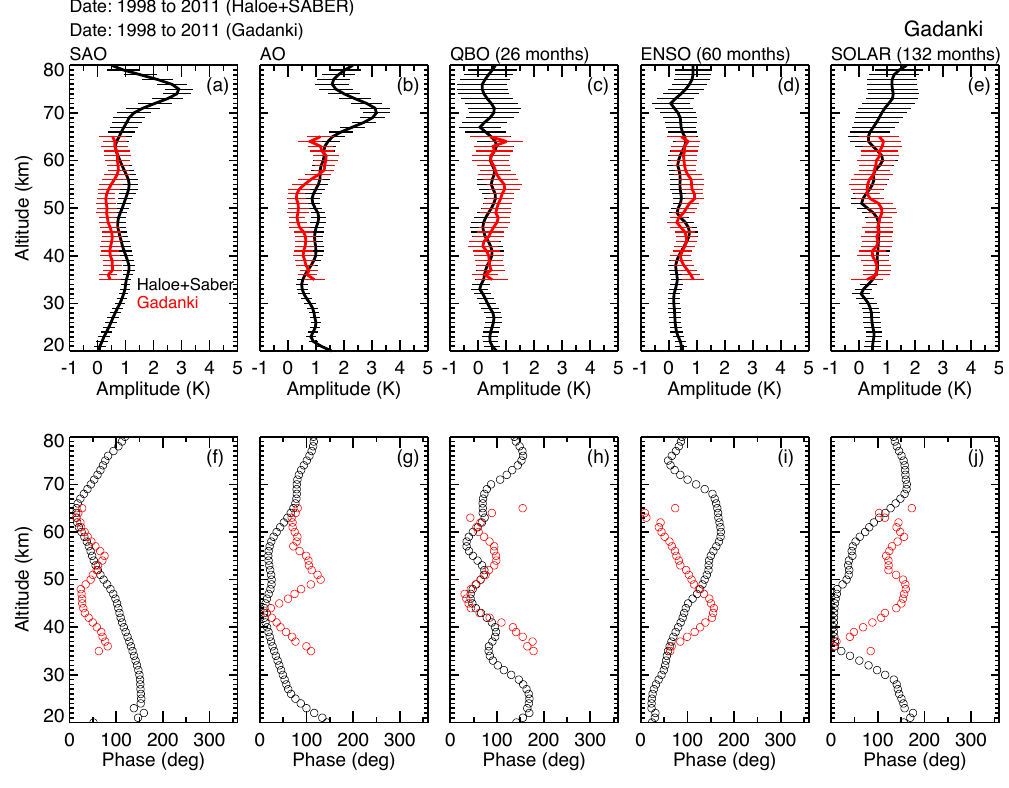
Figure 8: Same as figure 6 but over Gadanki location during 1998-2011. Fig. 8. Same as Fig. 6 but over Gadanki location during